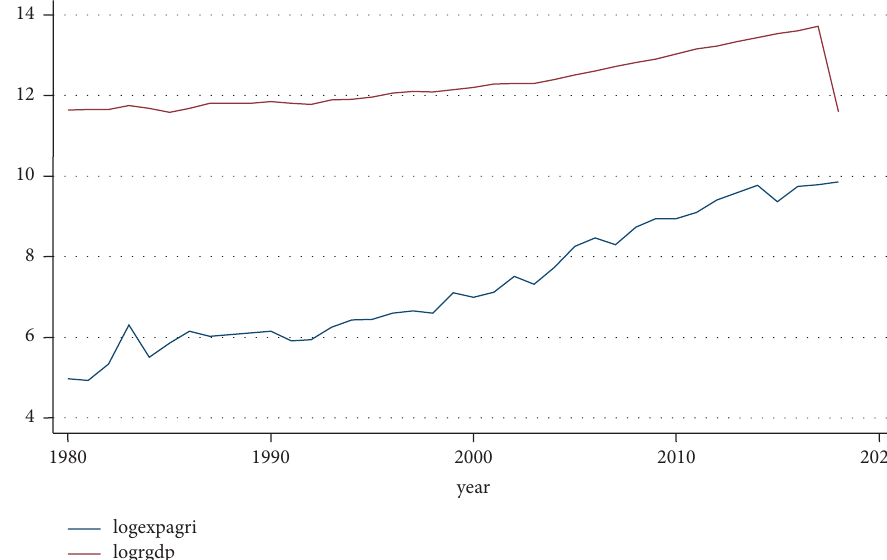
Figure 3: Trend expenditure on agriculture and RGDP. Source: own computation based on the data from MOFED and National Bank,